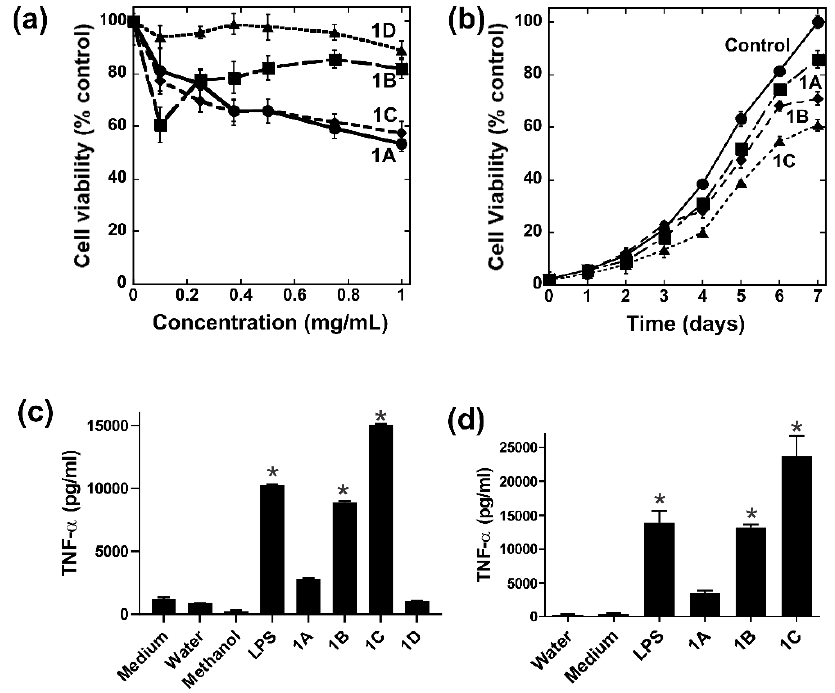
Figure 1. Immunomodulatory and antiproliferative activities of crude extracts obtained from R. badius . ( a ) Dose- and ( b ) time-dependent MTT cell viability assays on HeLa cells. The concentration used for the time-dependent experiment was ( b ) 0.5 mg/mL. At 1 mg/mL, crude extracts from specimens ( c ) CL86 and ( d ) CL152 were assessed for their ability to induce TNF- α production in RAW264.7 macrophage cells, as an indicator of immunomodulation. Lipopolysaccharide (LPS) was used as a positive control, while media, water, and methanol were used as negative controls. Results presented are representations of two separate experiments ( n = 2). Error bars show SD. One-way ANOVA (Tukey test) was used for statistical analysis. * p < 0.05 compared with the water control.